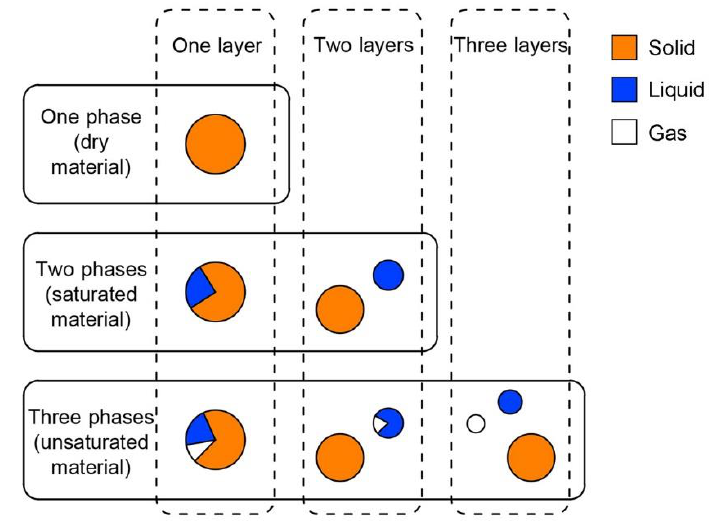
Figure 4. Scheme of the different approaches of the MPM (adapted from [44]).